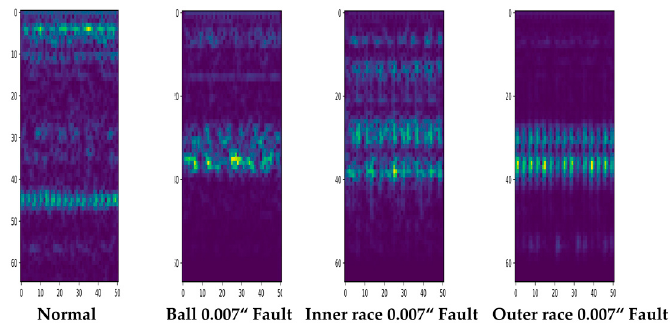
Figure 10. Examples of input spectrogram data of 65 × 50 size.